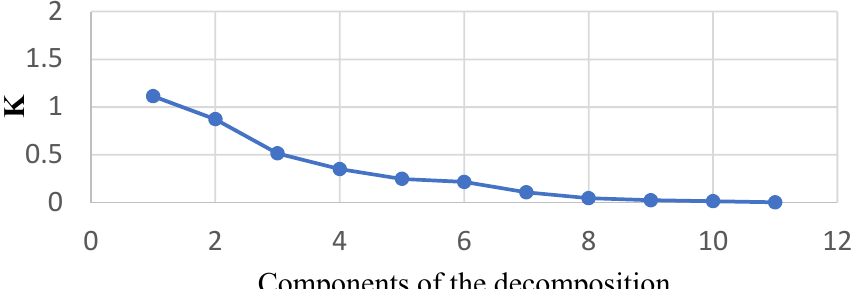
Figure 9. K entropy values of each level.